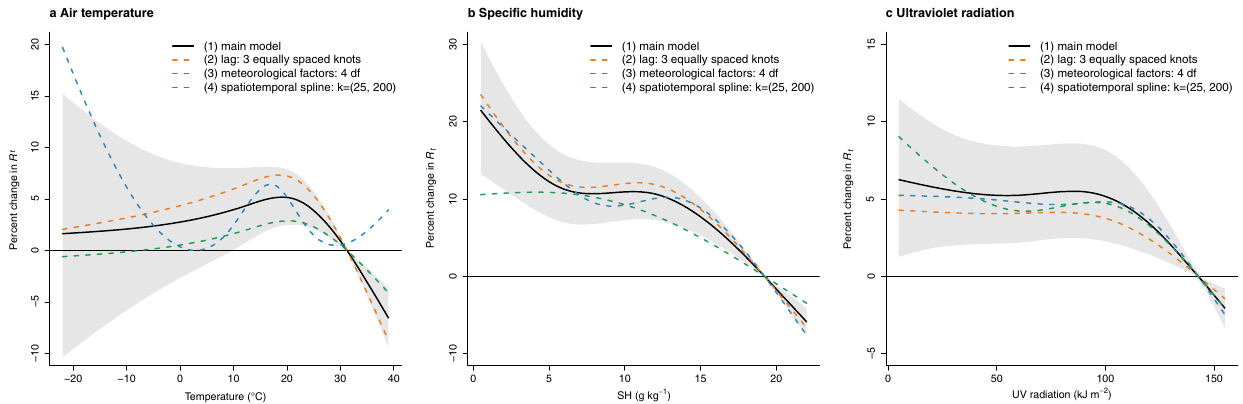
Fig. 2 The associations of air temperature, speci fi c humidity, and ultraviolet radiation with R t , under different choices of model. This fi gure shows the estimated exposure-response curves (meteorological factors vs. percent change in R t ) for the associations of air temperature ( a ), speci fi c humidity (SH) ( b ), and ultraviolet (UV) radiation ( c ) with reproduction number ( R t ) for SARS-CoV-2, with different modelling choices: (1) main model with 95% con fi dence interval (grey area): tensor product smooths to control for the temporal and spatial variations with a maximum of 30 and 200 knots (k), respectively, and cross-basis terms for meteorological factors, which are de fi ned by natural cubic splines with 3 df for both the exposure-response and lag- response association, with a maximum lag of 13 days; (2) rede fi ne the lag dimension using a natural cubic spline and 3 equally placed internal knots in the log scale; (3) change the df to 4 in the cross-basis terms for meteorological factors in the exposure-response function; (4) change the maximum number of knots to 25 in the fl exible natural cubic spline to control time trend in the tensor product smooths.